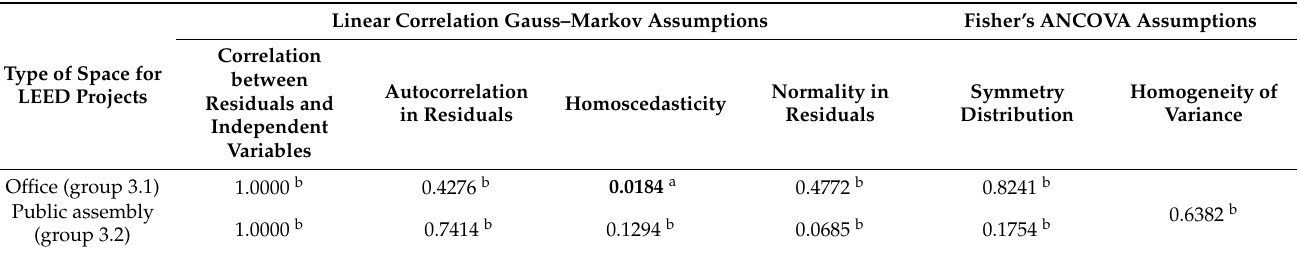
Table A3. Case 3: p -values of Gauss–Markov and Fisher’s ANCOVA assumptions where Y-variable is EAc7 achievement credit and X-covariate is project size from same LEED-NC v4 silver